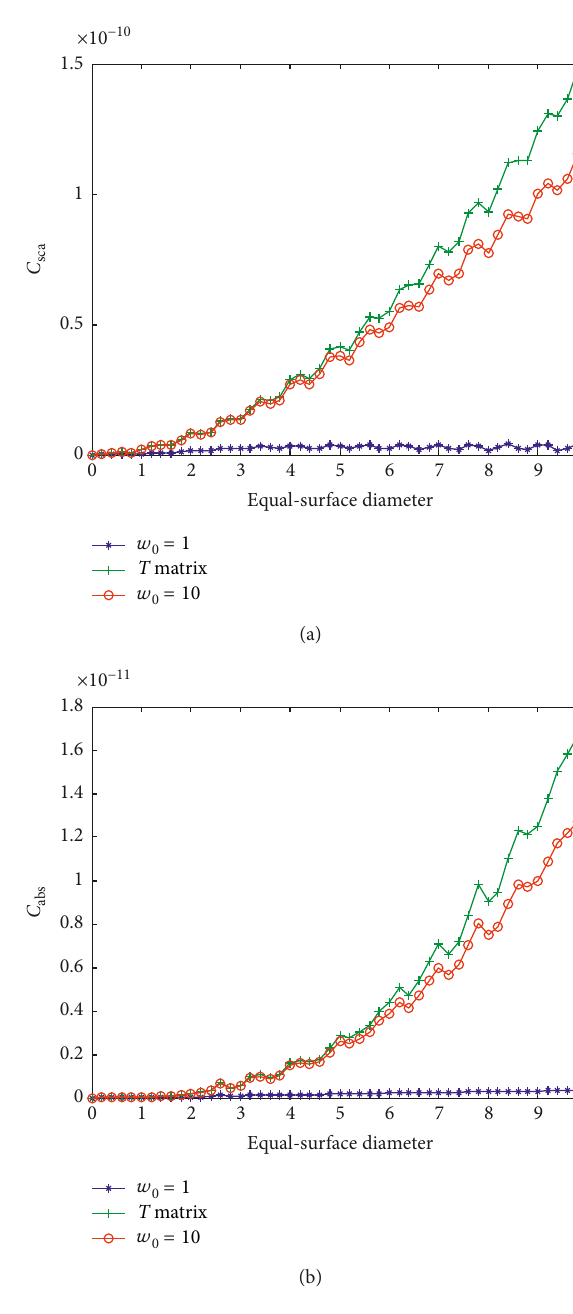
Figure 6: Scattering and absorbing cross sections of red clay particles ( λ 0.5, m 1.7 +0.001 i (cid:31) (cid:31)